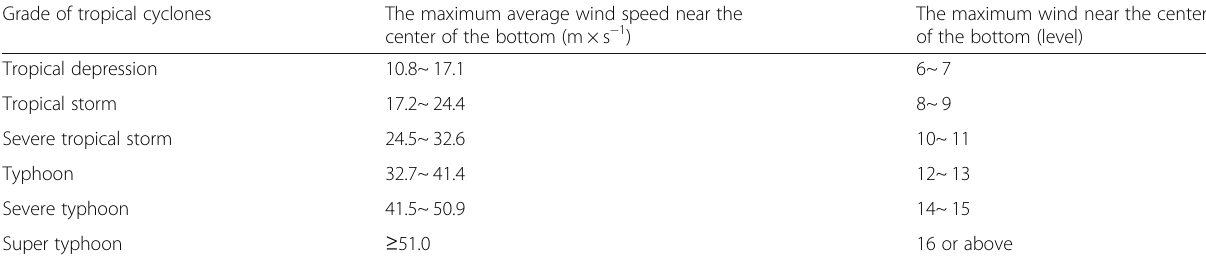
Table 2 National standards for tropical cyclones in China Grade of tropical cyclones